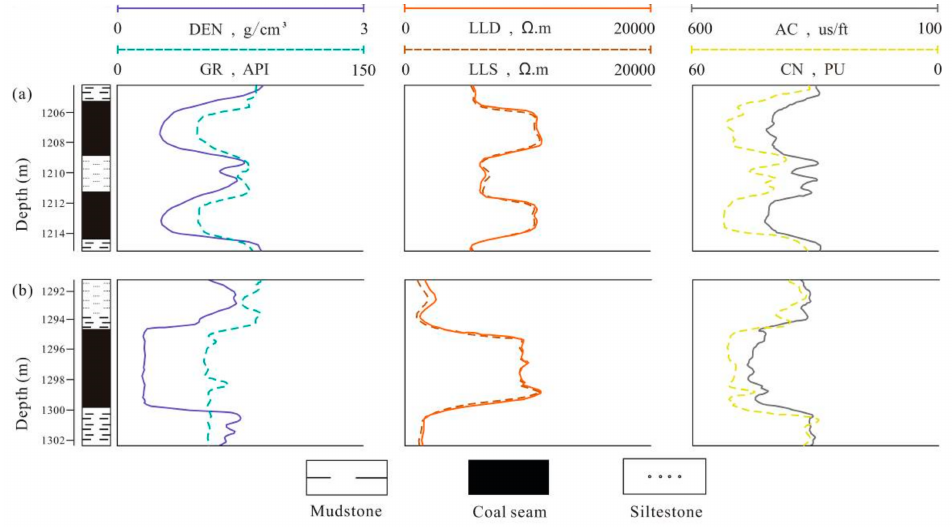
Figure 3. Logging response characteristic of coal reservoirs in the C51 well ( a ) and C84 well ( b ).